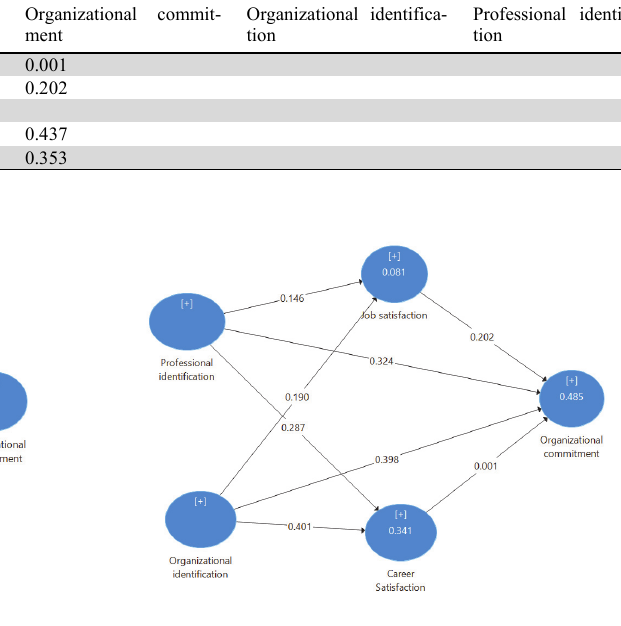
Fig. 2. Research model has no moderator variables Fig. 3. Impact coefficient results